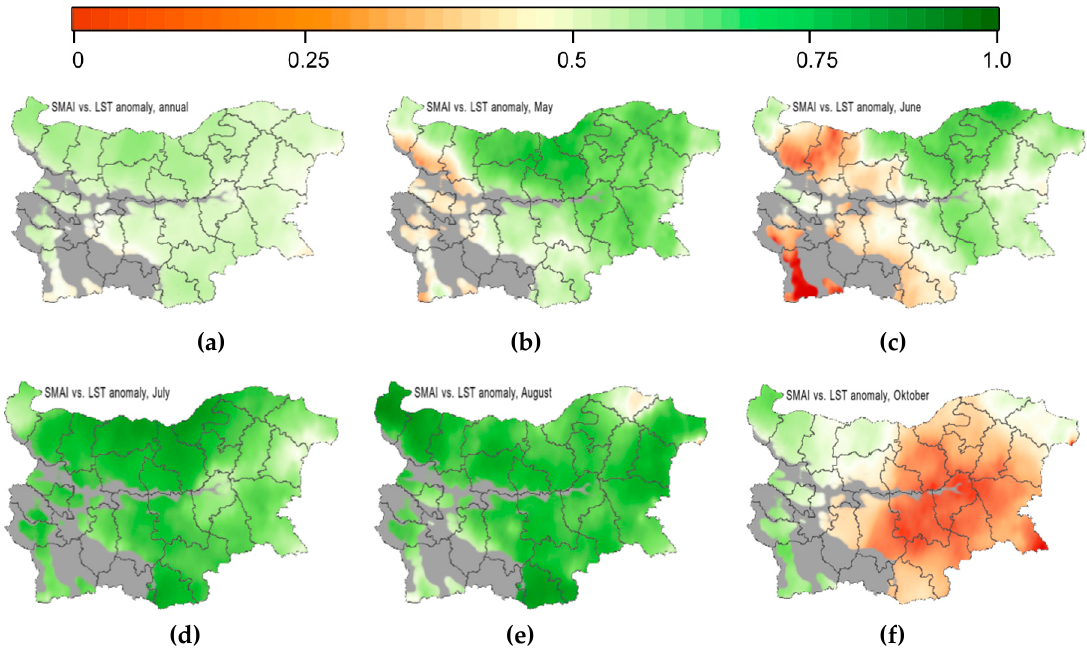
Figure 8. Spatial distribution over Bulgaria of correlation between the monthly mean anomalies of root zone SMAI and LSASAF LST (MSG retrieval) for ( a ) the whole growing season, ( b ) May, ( c ) June, ( d ) July, ( e ) August, and ( f ) October. Anomalies are calculated for the 2007–2018 period. Mountain regions above 800 m altitude are excluded with a mask.